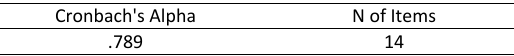
Table 4: Cronbach's alpha calculation (Reliability Statistics) Table 4: Cronbach’s alpha calculation (Reliability Statistics Cronbach's Alpha